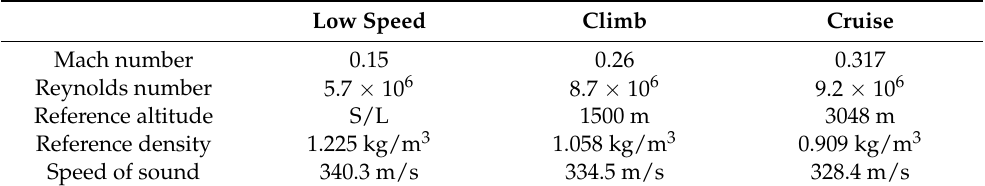
Figure 3. Convergence plot for lift coefficient ( a ) and drag coefficient ( b ). Cruise condition, M = 0.32, Re = 9.2 Mil.